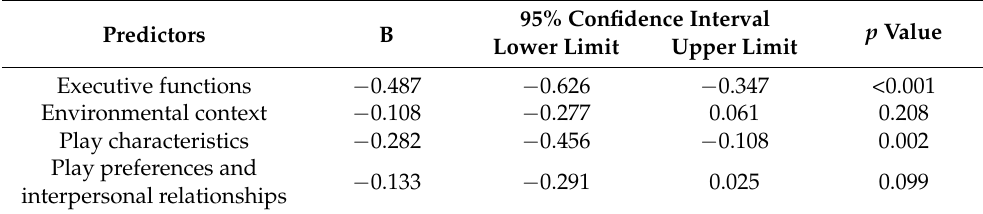
Table 6. Linear regression for psychosocial problems ( n =